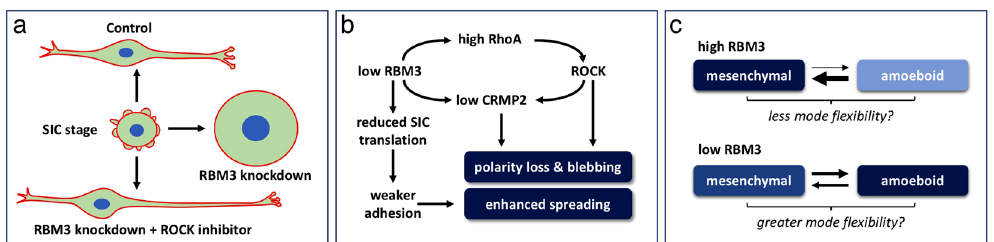
Figure 9. Model of RBM3’s influences on cell morphology and migration. ( a ) Schematic of the morphological trajectories taken by B104 cells under control, RBM3 knockdown, and RBM3 knockdown plus ROCK inhibitor conditions. Replated B104 cells initially exhibit SICs and a rounded morphology. Whereas control cells go on to adopt a bi- or multi-polar shape, cells lacking RBM3 lose polarity and undergo exaggerated spreading. Inhibition of ROCK during replating of RBM3 knockdown cells rescues polarity but enhances process elongation. ( b ) Diagram of proposed mechanisms by which RBM3 regulates cell polarity and spreading. Knockdown of RBM3 results in parallel changes in translation and a RhoA-ROCK-CRMP2 pathway. Elevated RhoA expression activates ROCK, a kinase involved in the transition from a mesenchymal to an amoeboid state. Reduced levels of CRMP2, a microtubule binding protein that is inhibited by ROCK phosphorylation, contributes to loss of polarity. ( c ) Schematic of hypothesized effects of RBM3 expression level on transitions between mesenchymal and amoeboid states. High levels of RBM3 lock cells into a highly polar, mesenchymal like mode of migration. Low RBM3 may favor an amoeboid state, but still be permissive to transitions between amoeboid and mesenchymal modes of migration, so-called MAT and AMT, respectively. This is may enhance metastasis of cancers by enhancing migration mode